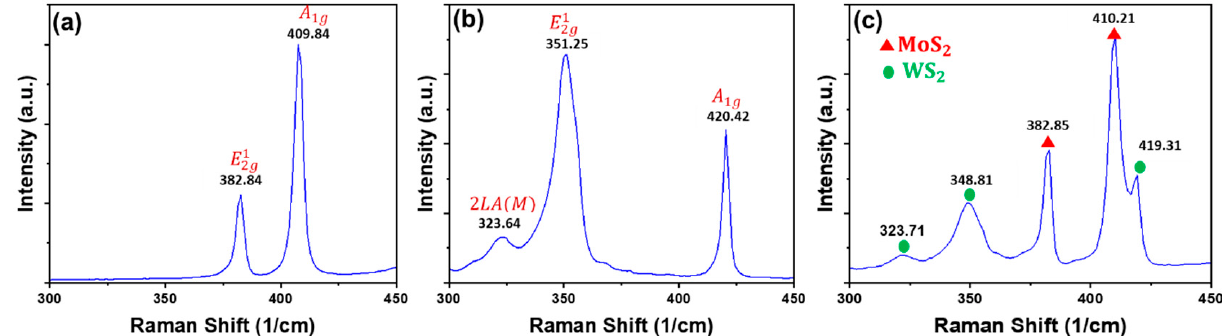
Figure 2. Vibrational modes obtained under 532 nm laser excitation for the ( a ) MoS 2 , ( b ) WS 2 and ( c ) Mo x W 1-x S 2 samples.